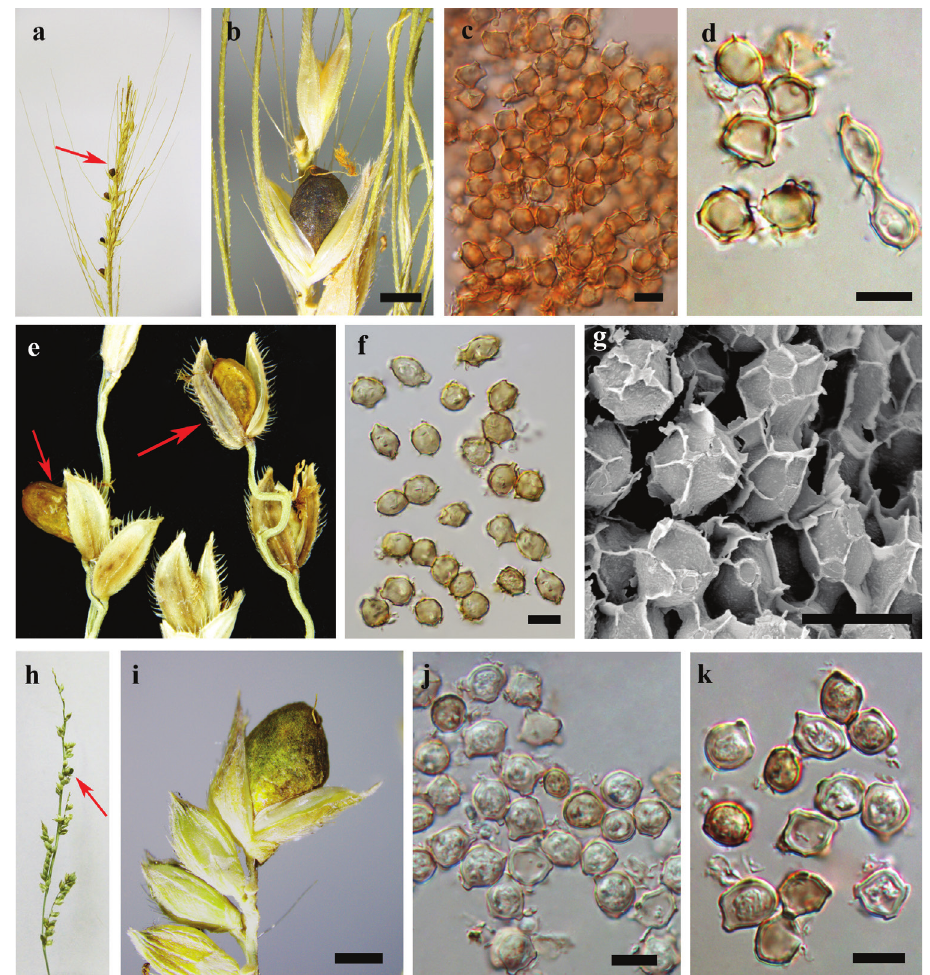
Figure 2. a–d Moesziomyces kimberleyensis (holotype BRIP 51843) e–g Moesziomyces globuligerus (BRIP 27384) h–k Moesziomyces antarcticus (HMAS 60130). a, b: sori. c, d, f, j, k: spores under LM. g: spores under SEM. Scale bars: 1 mm ( b, i ); 10 μm ( c, d, f, g, j, k ).